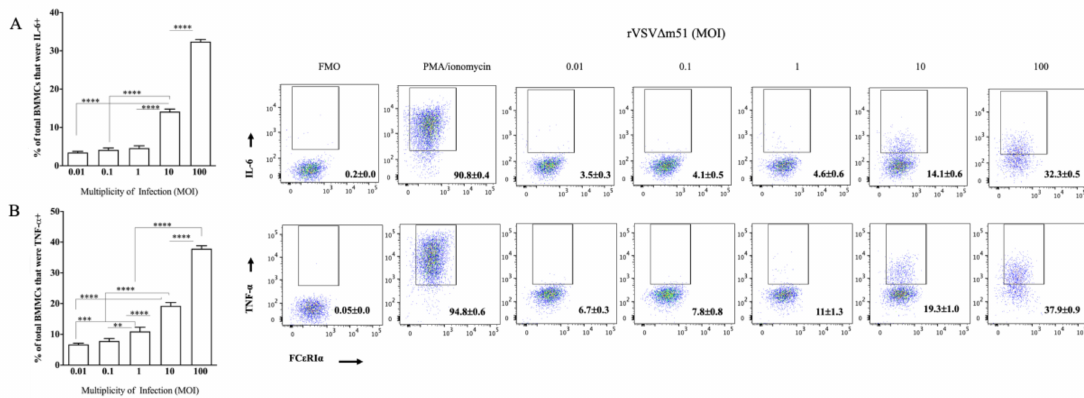
Figure 3. Cytokine responses of murine bone-marrow-derived mast cells (BMMCs) to recombinant vesicular stomatitis virus (rVSV ∆ m51) were dose-dependent. BMMCs were infected with rVSV ∆ m51 at a multiplicity of infection (MOI) of 0.01, 0.1, 1, 10, or 100. After 16 h, the cells were stained for the surface markers Fc ε RI α and c-kit as well as intracellular cytokines interleukin (IL)-6 and tumor necrosis factor (TNF)- α . The cells were then analyzed by flow cytometry, and fluorescence minus one (FMO) controls were used to set gates to identify IL-6 + and TNF- α + cells. Graphs and representative dot plots show means and standard deviations pooled from four experimental replicates of ( A ) IL-6 and ( B ) TNF- α expression in Fc ε RI α + c-Kit + mast cells after infection with rVSV ∆ M51 or treatment with phorbol 12-myristate 13-acetate (PMA) and ionomycin as a positive control stimulus. Two-way analysis of variance with Tukey’s multiple comparison test was used to define statistical significance as ** p < 0.001; *** p < 0.0005; **** p <